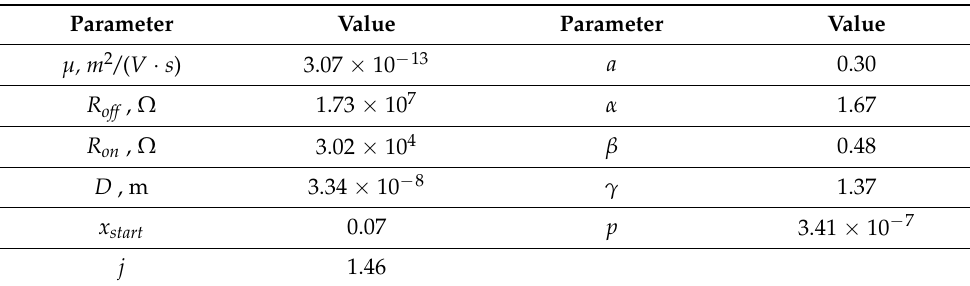
Table 9. Optimal values of parameters of the nonlinear drift model with Li window function, obtained by approximation of the experimental loop.